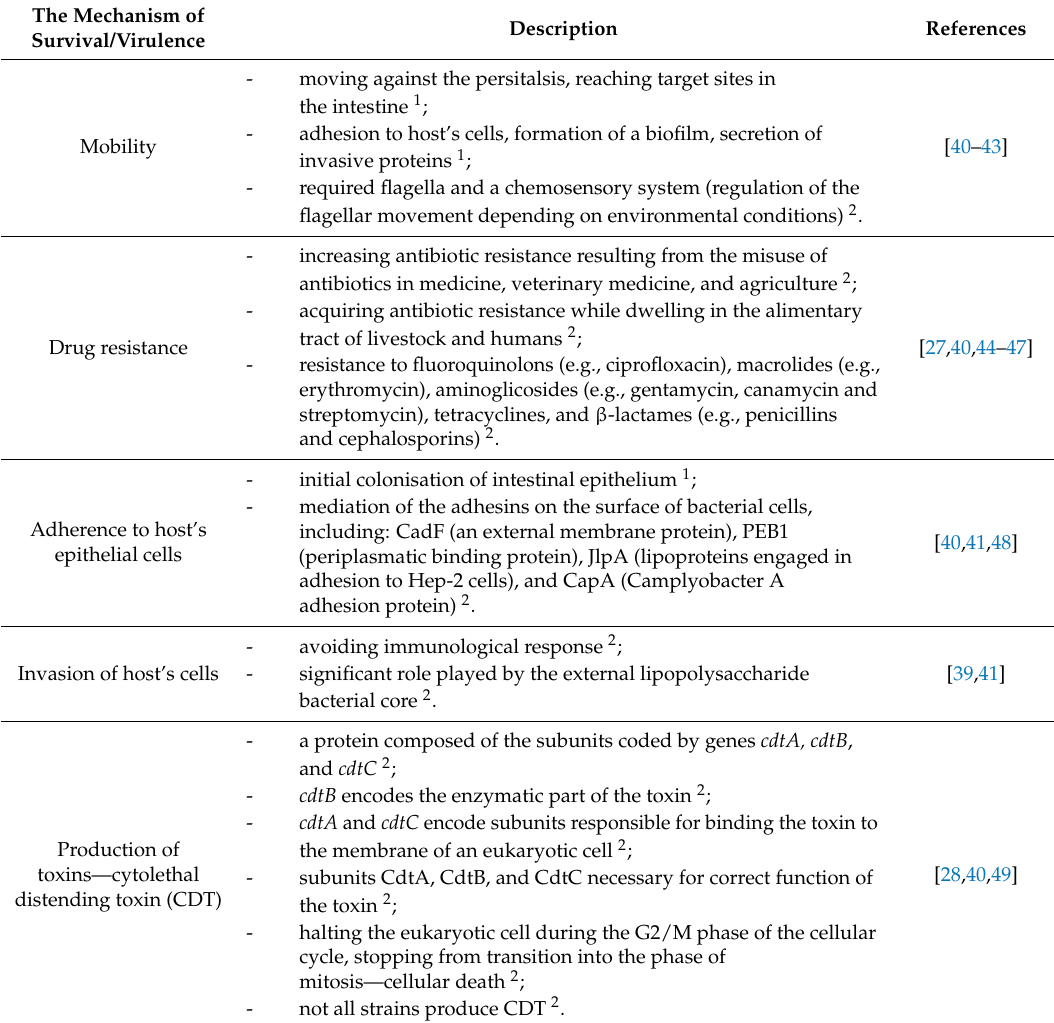
Table 1. Attributes of Campylobacter genus bacteria allowing them to infect and survive in a host